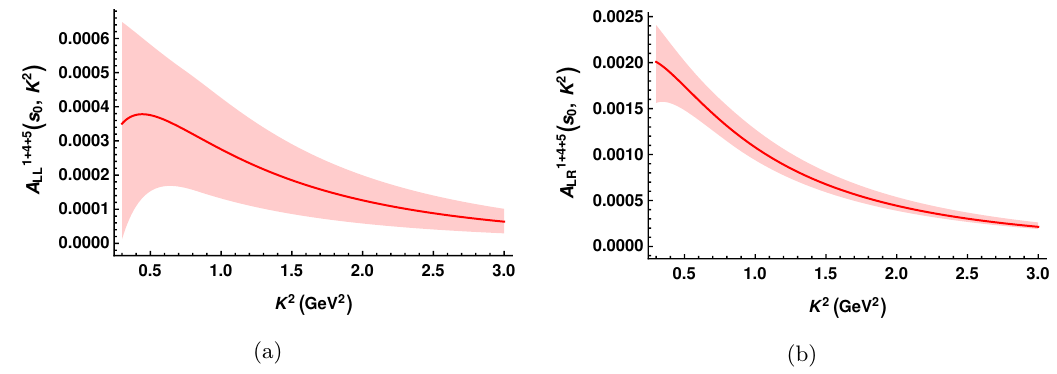
( s 2 ) (left pannel) and A 1+4+5 Figure 10 . The physical FF, A 1+4+5 0 , K LL are shown at s = (1 . 44 GeV ) 2 and M 2 = 2 GeV 2 along with the uncertainties associated with the 0 parameters involved in proton DAs. The bands represents the uncertainties.